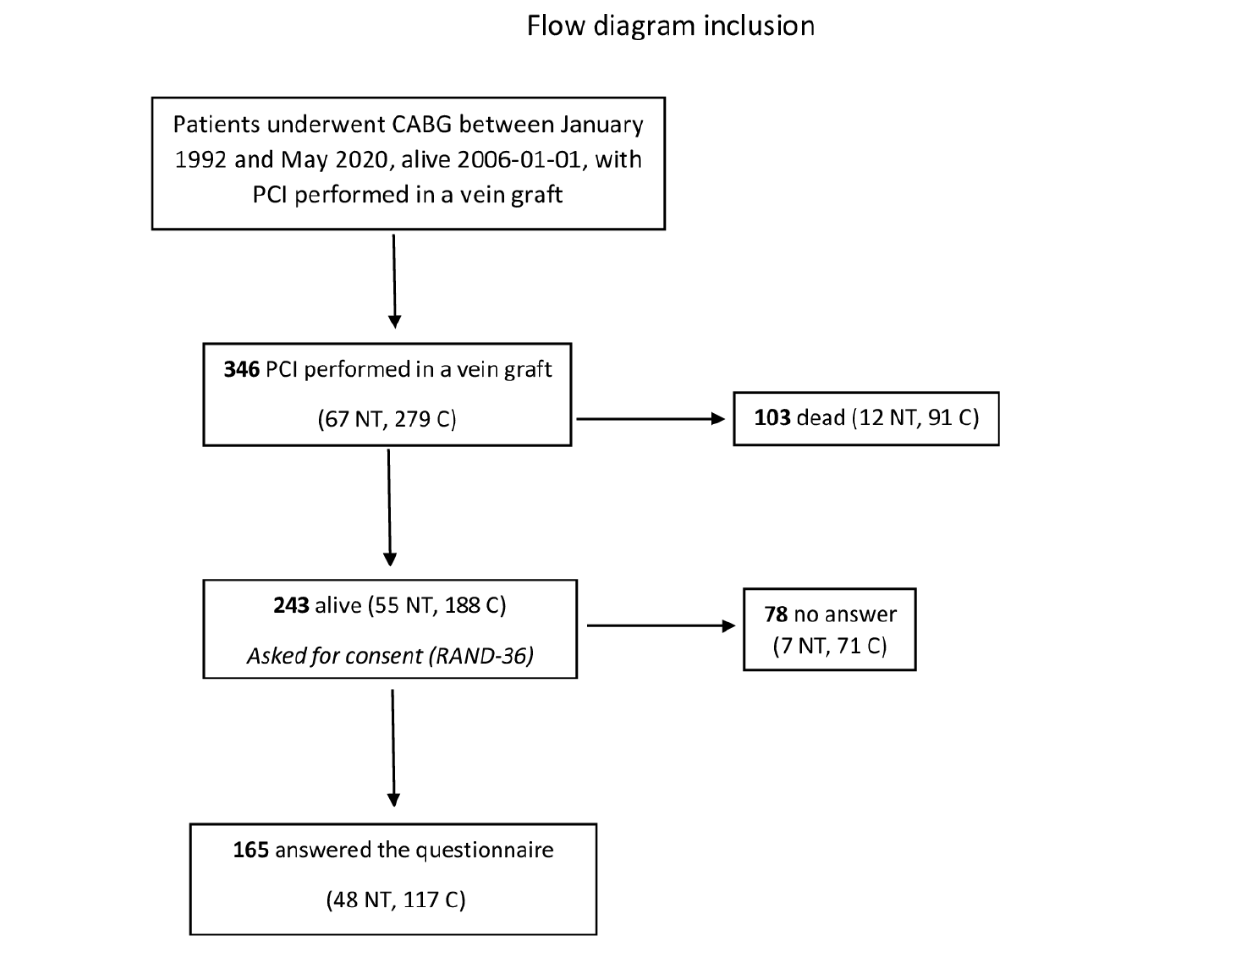
Fig. 1 - PRISMA flowchart of the individuals included in the study. C=conventional graft; CABG=coronary artery bypass grafting; NT=no- touch graft; PCI=percutaneous coronary